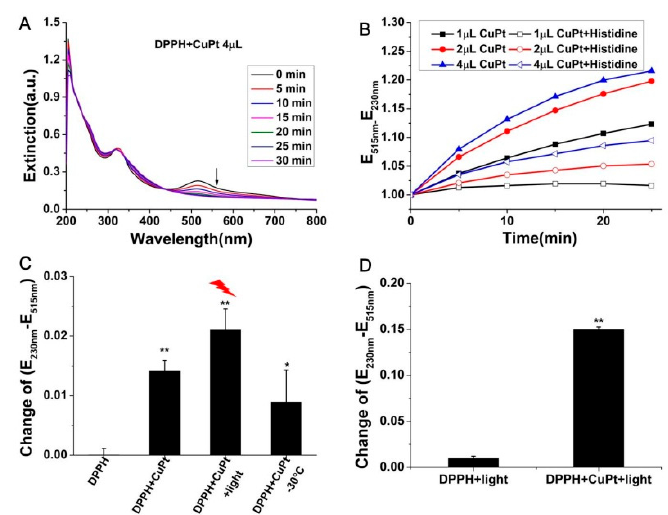
Figure 6. DPPH scavenging capacity and the photo-enhanced activity of CuPt. ( A ) UV-Vis-NIR spectra of DPPH after incubation with 4 μ L CuPt for 30 min at the time interval of 5 min. ( B ) The extinction changes and the inhibition effect of histidine for DPPH in different concentration of CuPt. ( C ) The photo-enhanced oxidation of DPPH with 1 μ L CuPt after 5 min. The temperature was 30 °C under the light after 5 min. ( D ) The photo-enhanced oxidation of DPPH with 4 μ L CuPt after 15 min. The concentrations were [DPPH] = 25 μ M, [histidine] = 6.40 mM for ( A ), ( B ), ( C ) and ( D ).